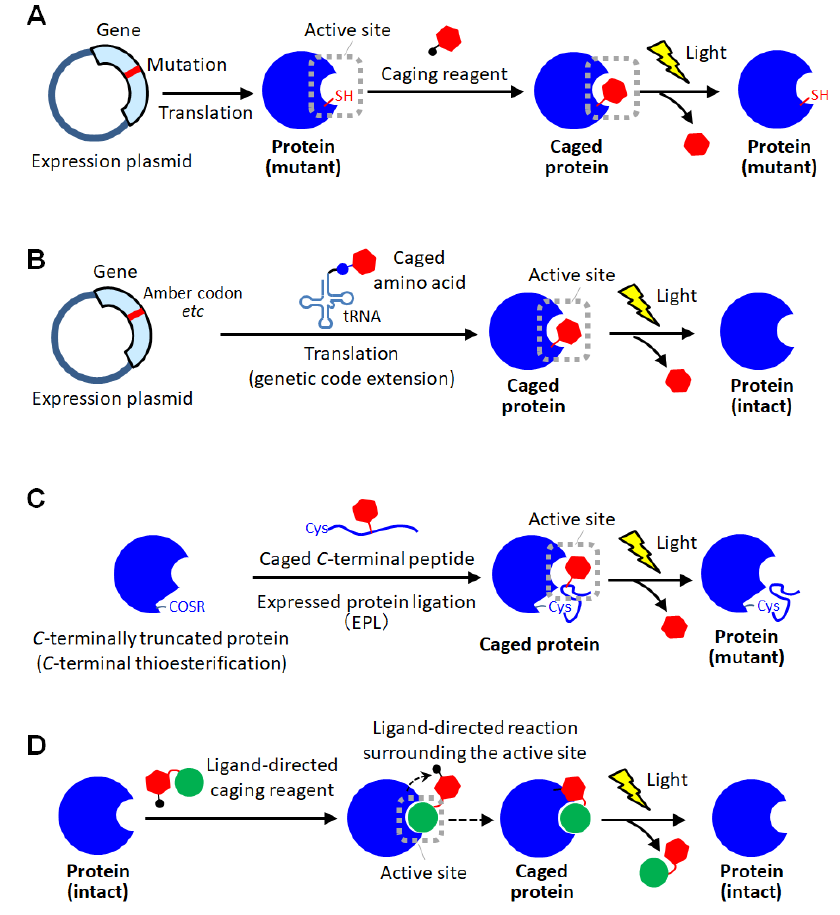
Figure 2. Schematic illustration of site-specific caging of proteins. ( A ) Caging based on cysteine mutagenesis. ( B ) Caging based on unnatural amino acid introduction using genetic code extension technologies. ( C ) Caging based on protein semi-synthesis using expressed protein ligation (EPL). ( D ) Caging based on ligand-directed chemistry.